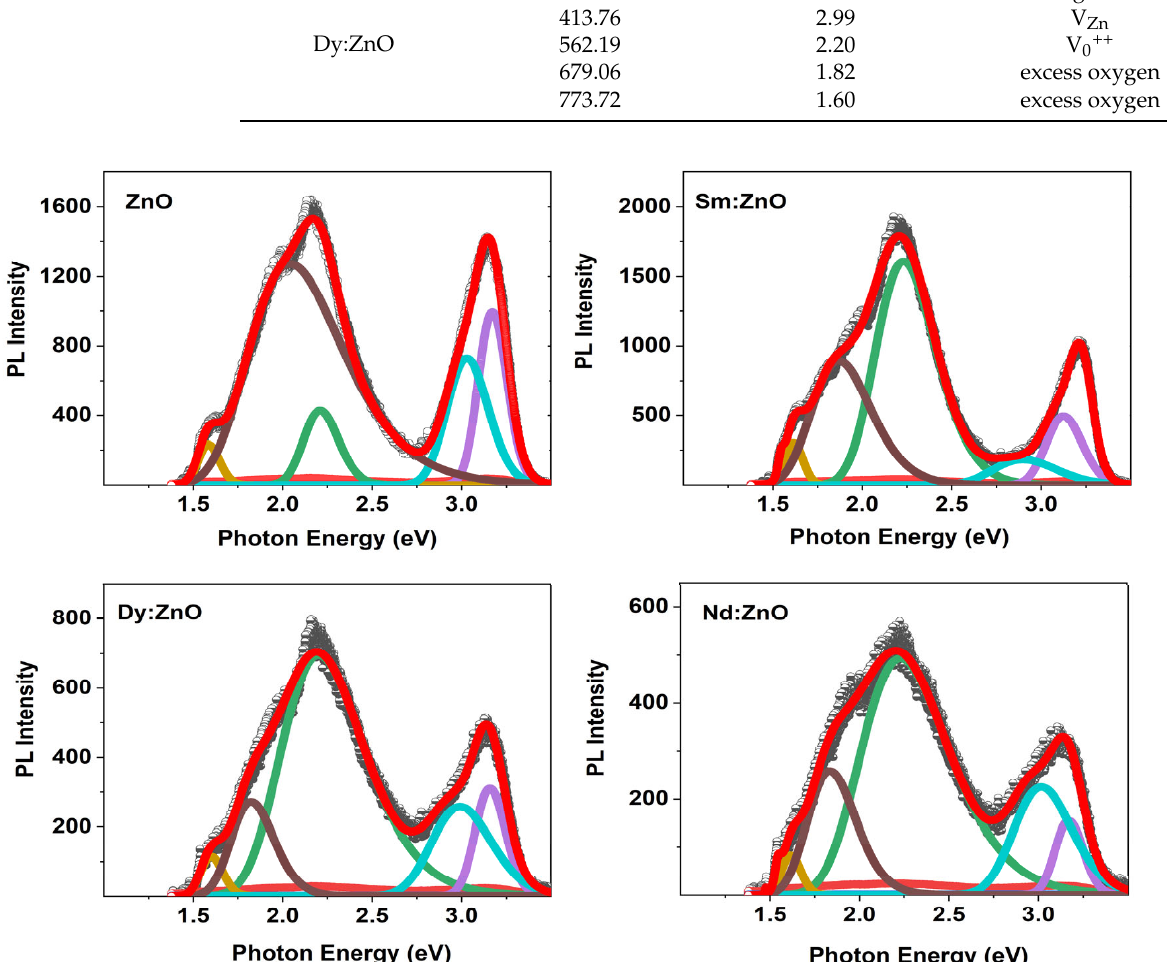
Figure 9. Gaussian fitted PL spectra for all synthesized samples. Table 2. The peak positions and their origin of de ‐ convoluted PL spectra for all samples.